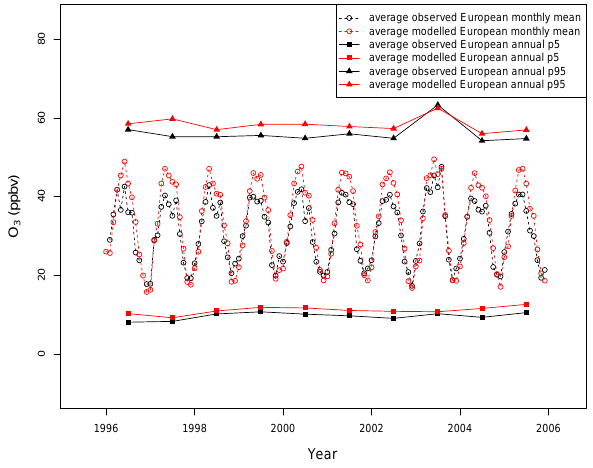
Fig.13. AcomparisonoftheEuropeanaverage O 3 observedmonthlymeanandannual5 th and95 th percentilesandtheCHIMEREmodel outputforall158sitelocations Fig. 13. A comparison of the European average O 3 observed monthly mean and annual 5th and 95th percentiles and the CHIMERE model output for all 158 site